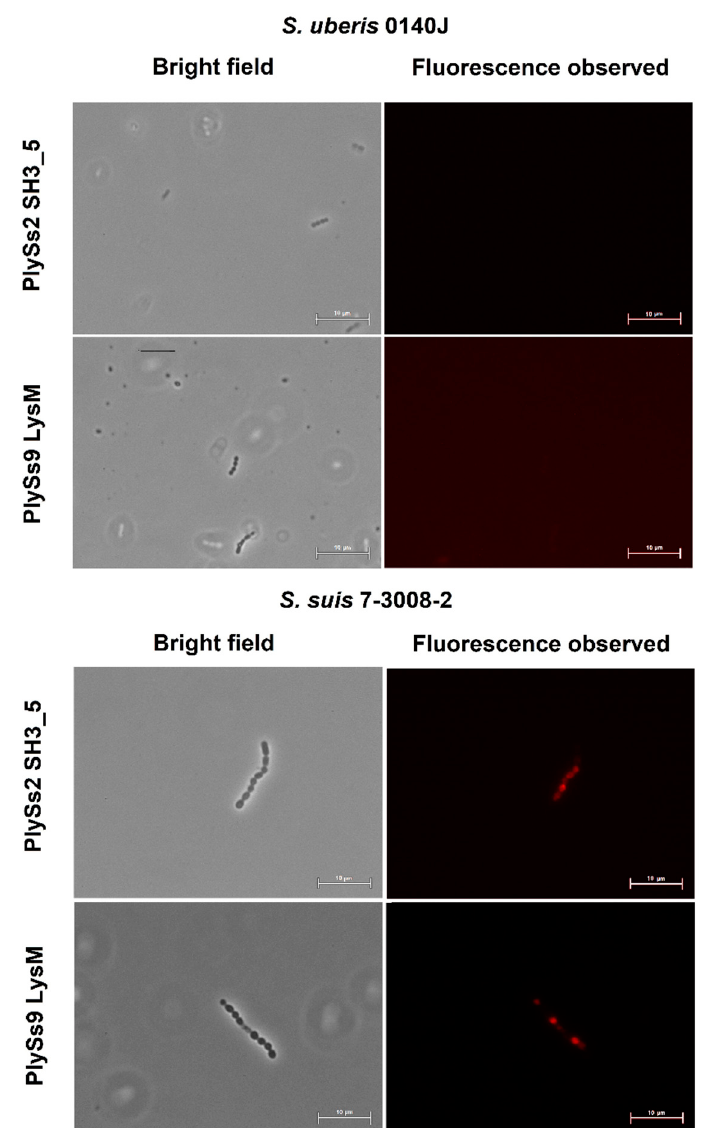
Figure 5. Bright field and fluorescent images of mid-log phase S. uberis 0140J observed by microscopy after incubation with the Alexa Fluor 555 conjugated PlySs2 SH3_5 and PlySs9 LysM cell wall binding subdomains. S. suis 7-3008-2 was included as positive control. Scale bars measure 10 µm.